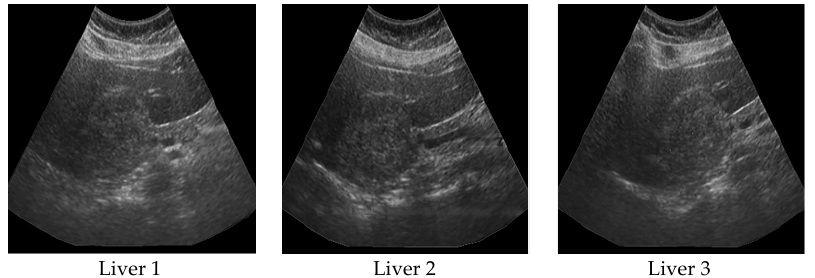
Figure 1. Reference ultrasound images [7] used in our work.